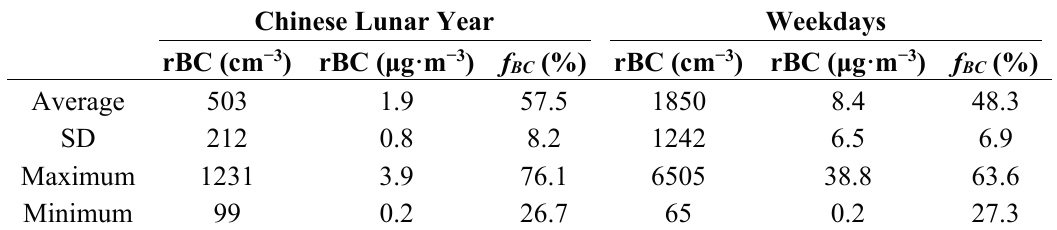
Figure 3. Time series of the hourly averaged refractory black carbon (rBC) number and mass concentrations, the number fraction of thickly-coated rBC and the CO mixing ratio during the Chinese Lunar Year (CLY) and on weekdays. Table 1. Summary of the rBC number and mass concentrations, as well as the number fractions of thickly-coated rBC ( f BC ) during the Chinese Lunar Year and on